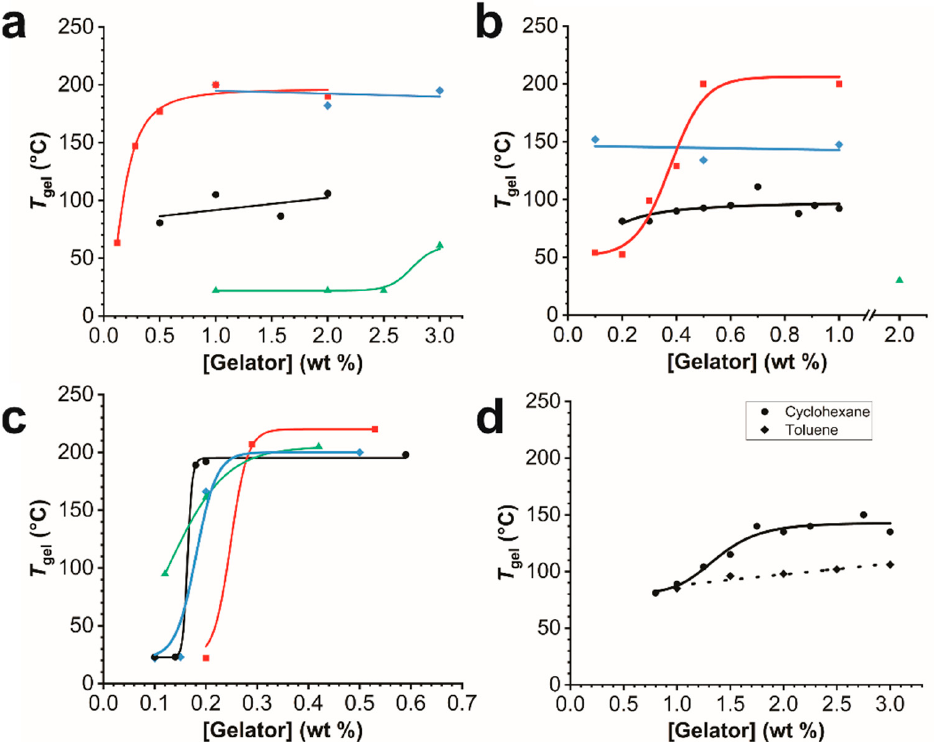
Figure 4. Gel-to-sol transition temperature ( T gel ) dependence on gelator concentration for gels with ( a ) xylenes, ( b ) decalin, ( c ) paraffin oil, and ( d ) cyclohexane (solid) and toluene (dotted). ISA12 (diamonds, blue), ISA16 (squares, red), ISA16L (triangles, green), and ISA24 (circles, black). In contrast, T gel (max) for the paraffin gels with each gelator were very similar (~200– 220 ° C). However, the minimum concentration at which T gel (max) occurs decreased in the order of ISA24 (0.15 wt%) < ISA16L ~ ISA12 (~0.25 wt%) < ISA16 (~0.30 wt%), which cor-